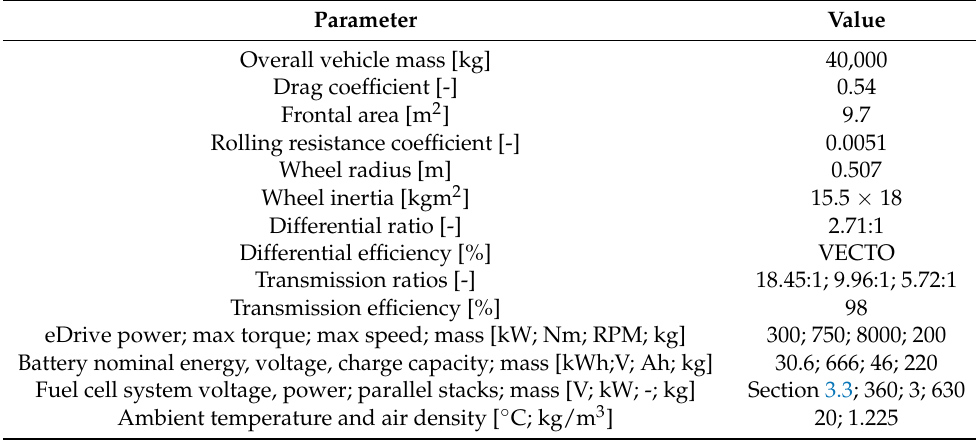
Table 5. Vehicle specifications for HD fuel cell truck